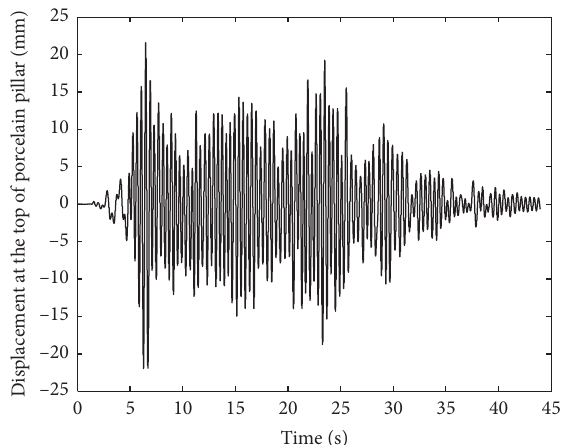
Figure 20: Displacement at the top of porcelain pillar ( a � 0.1g, η � 20,000).